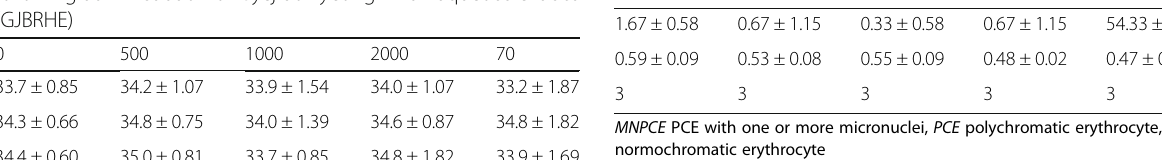
Table 4 Body weight changes of Micronucleus test in mice following administration of Gyejibokryeong-hwan aqueous extract